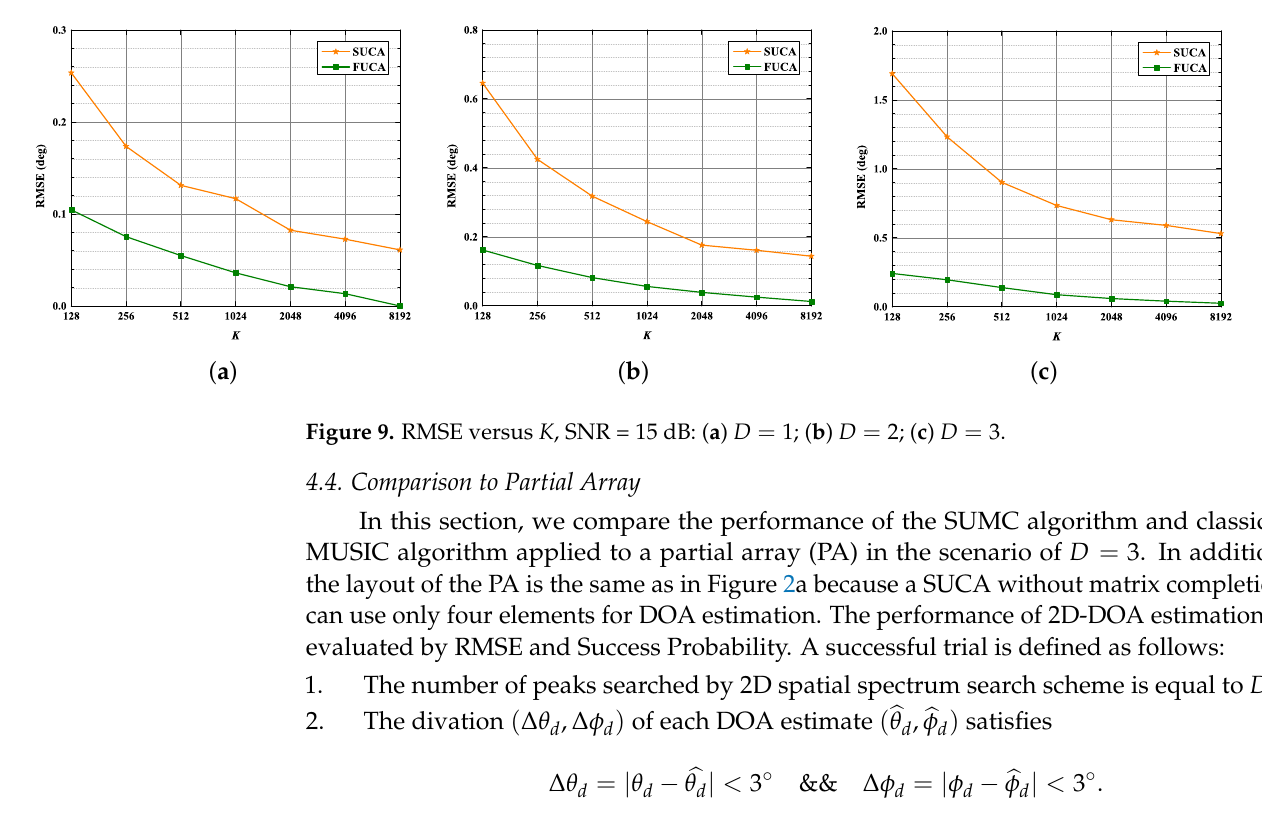
Figure 8. RMSE versus SNR, K = 1024: ( a ) D = 1; ( b ) D = 2; ( c ) D = 3.